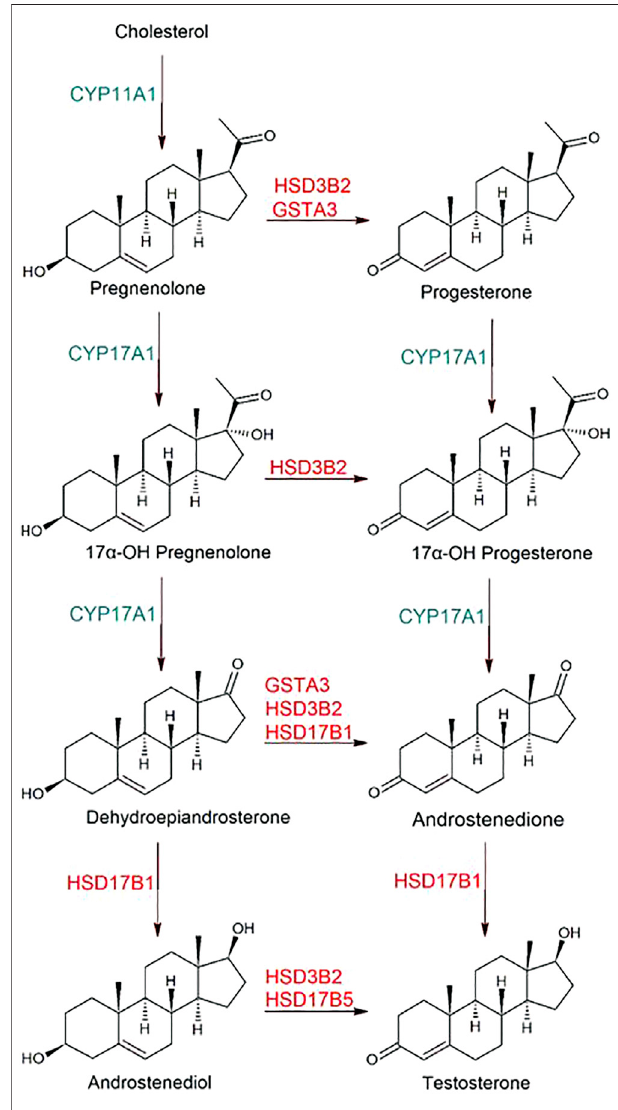
FIGURE 7 | Biosynthetic reactions leading from cholesterol to the steroid hormones progesterone and testosterone. The chemical transformations in the left column represent the delta5-pathway and those in the right column the delta4-pathway. Genes indicated are encoding enzymes involved in the processesthosesofaridenti fi edbytranscriptomeanalysisduringthepregnancy of mares (Loux et al., 2020). CYP, cytochrome P450; GST, glutathione transferase; HSD, hydroxysteroid dehydrogenase. The 3-keto intermediates derived by oxidation ofthe 3-hydroxygroups of17 α -hydroxypregnenoloneand androstenediolmay alsobeGSTsubstrates, buttheyhavenotyetbeentested. Furtherreactionsfromprogesteronetocorticosteroids,andfromandrostedione and testosterone to estrogens are not